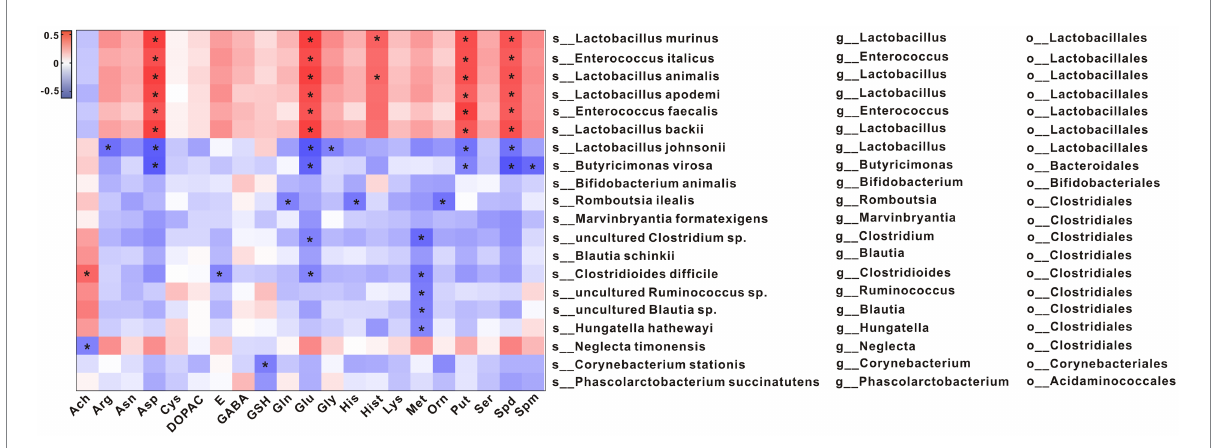
FIGURE 5 Spearman correlations between metabolites and the gut microbial communities at the species level. * p <